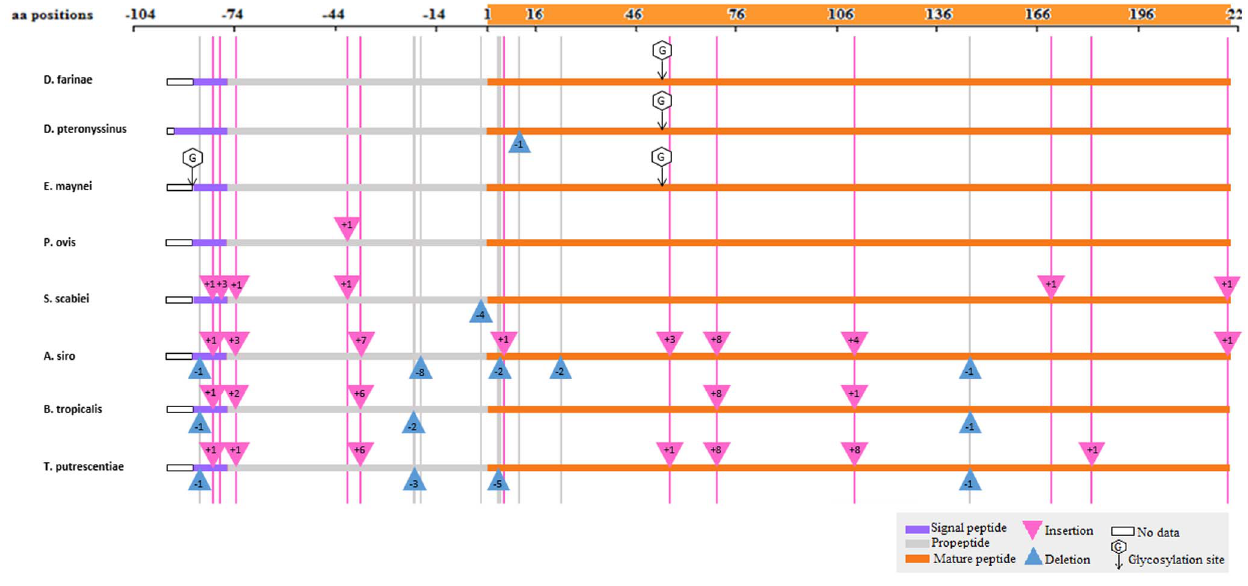
Figure 5. Translated Der f 1 polypeptide aligned with cysteine proteases of other mite species: Dermatophagoides pteronyssinus (Der p 1: present study, and U11695.1for Der p 1 to complete our partial signal peptide sequence), Euroglyphus maynei (Eur m 1:AAC82352.), Psoroptes ovis (Pso